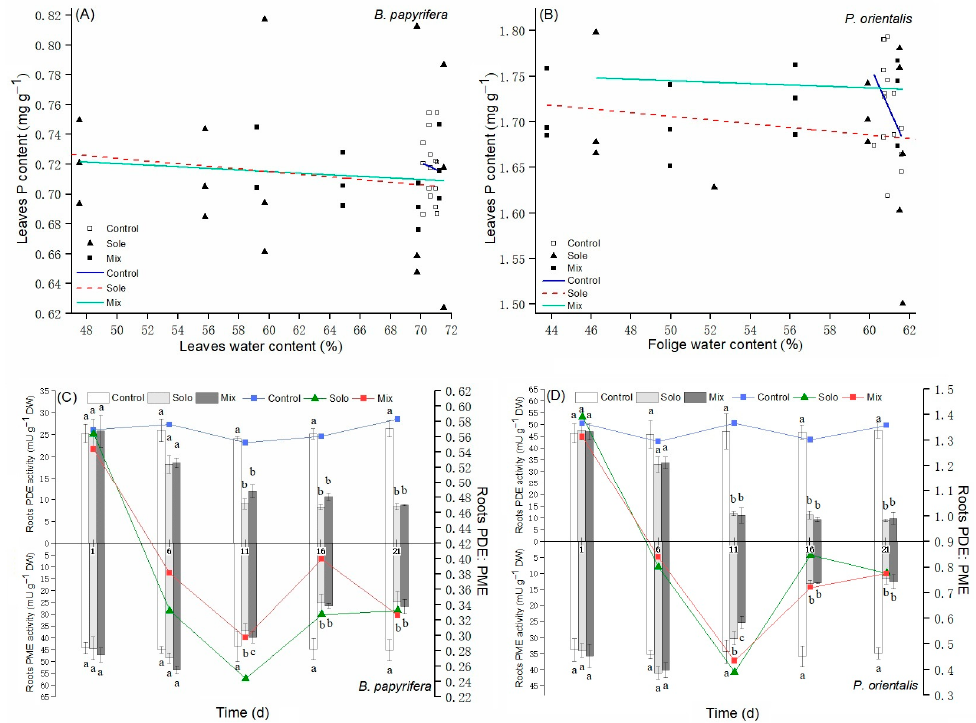
Figure 6. The leaves’ P content relative to water content in B. papyrifera ( A ) and P. orientalis ( B ). Curve fits in the graphs are separate linear regressions. The roots’ PDE: PME ratio in B. papyrifera ( C ) and P. orientalis ( D ). Letters denote significant differences among different planting and treatment modes ( p < 0.05).